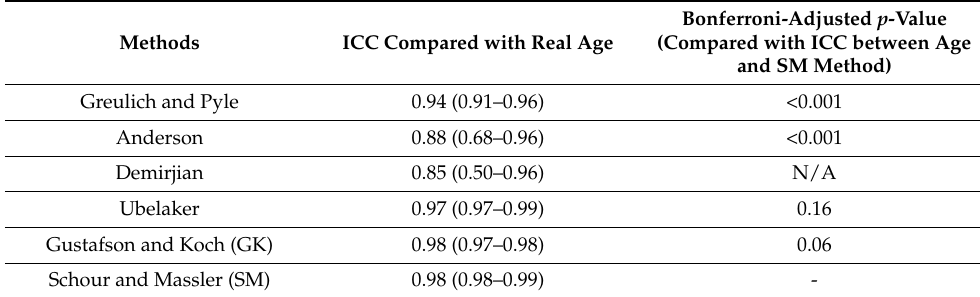
Table 2. Intraclass correlation coefficients (ICC) with 95% confidence intervals (CI).